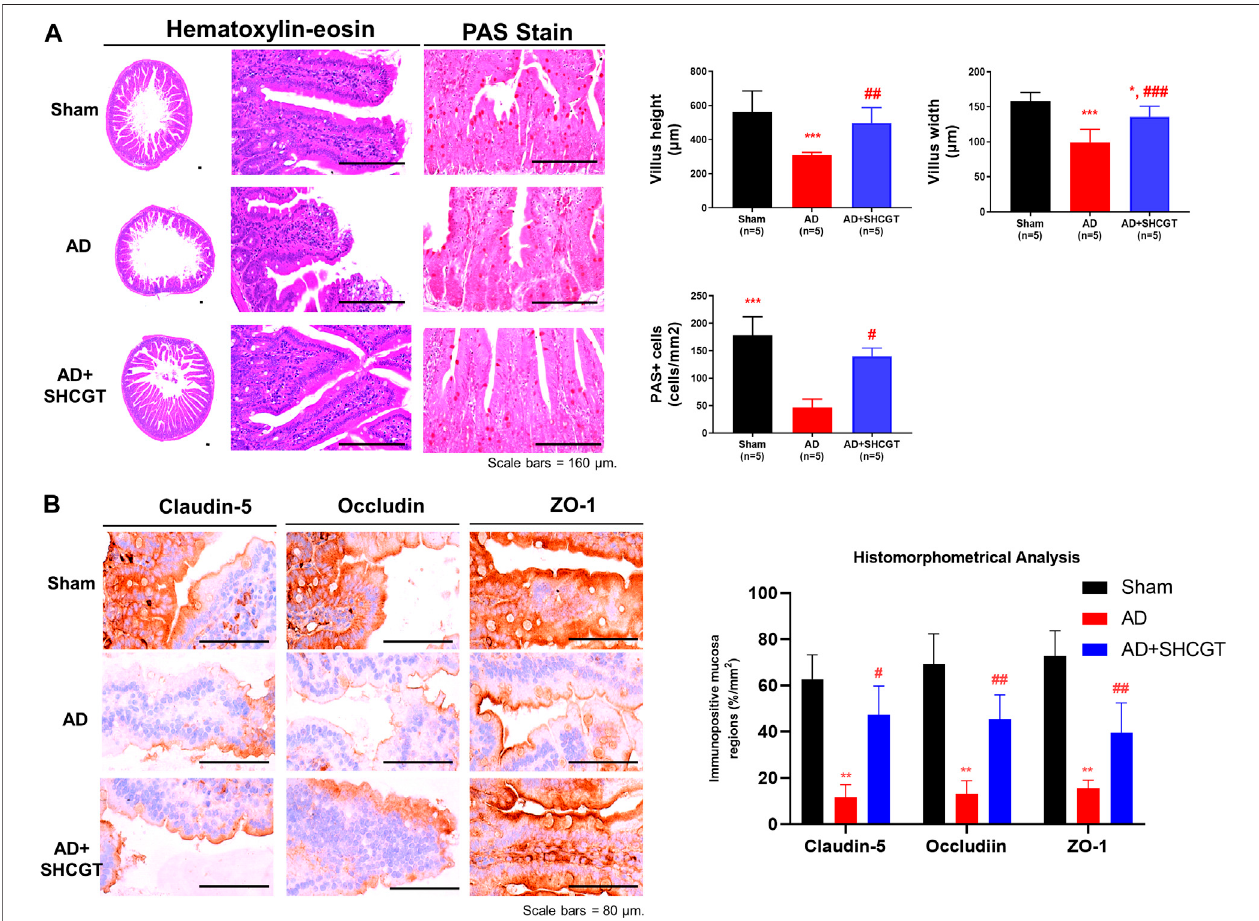
FIGURE 6 | SHCGT improved the damaged intestinal barrier system in mice with DNCB-induced AD. (A) Hematoxylin-eosin and PAS staining of intestinal villi. SHCGT signi fi cantly reduced the mean villus height and width as well as PAS+ cell numbers in mice with DNCB-induced AD. (B) Immunohistochemistry staining for claudin-1, occludin, and ZO-1 in the intestine. Quantitative imaging analysis showed that SHCGT recovered the function of the intestinal barrier system, with losses of tightjunctionalmarkers(claudin-5,occludin,andZO-1).** p < 0.01,*** p < 0.001vs.sham; # p < 0.05, ## p < 0.01, ### p < 0.001vs.AD.AD,atopicdermatitis;DNCB, 2,4-dinitrochlorobenzene; PAS, periodic acid Schiff; SHCGT, Sihocheonggan-Tang ; ZO-1, zonula occludens-1.